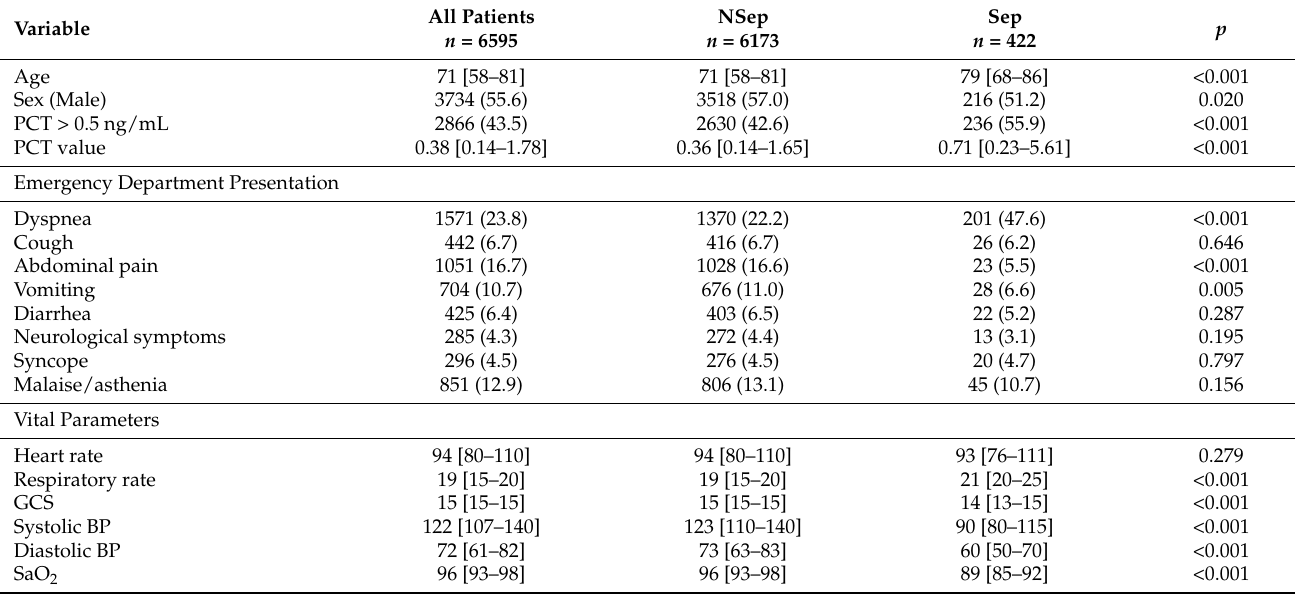
Table 1. Demographic and clinical characteristics of the patients included in the study. Values are shown separately for patients with suspected sepsis (Sep group) and non-suspected sepsis (NSep) at Emergency Department admission.